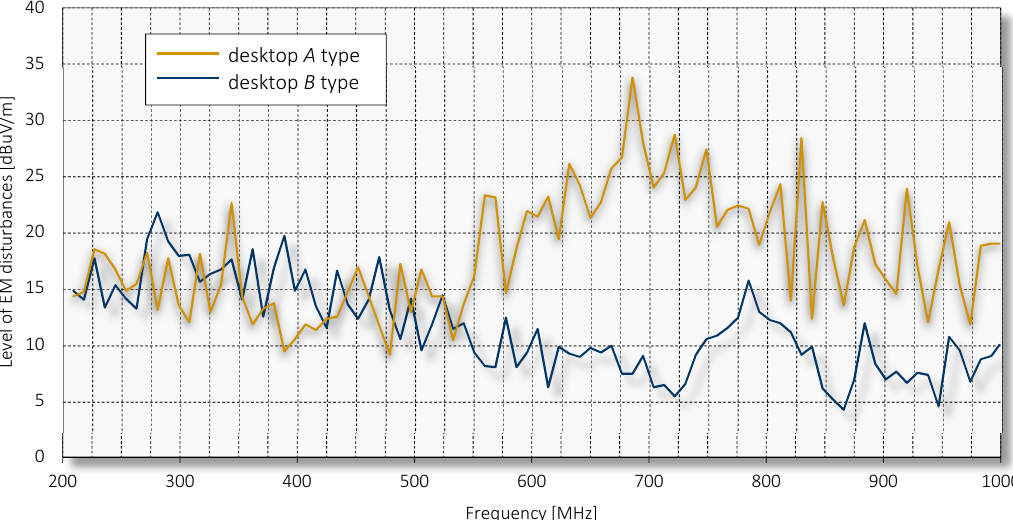
Figure 11. Differences of measured levels of EM disturbances (valuable emissions) for two types of desktop computers in the range of frequencies from 200 MHz to 1 GHz.